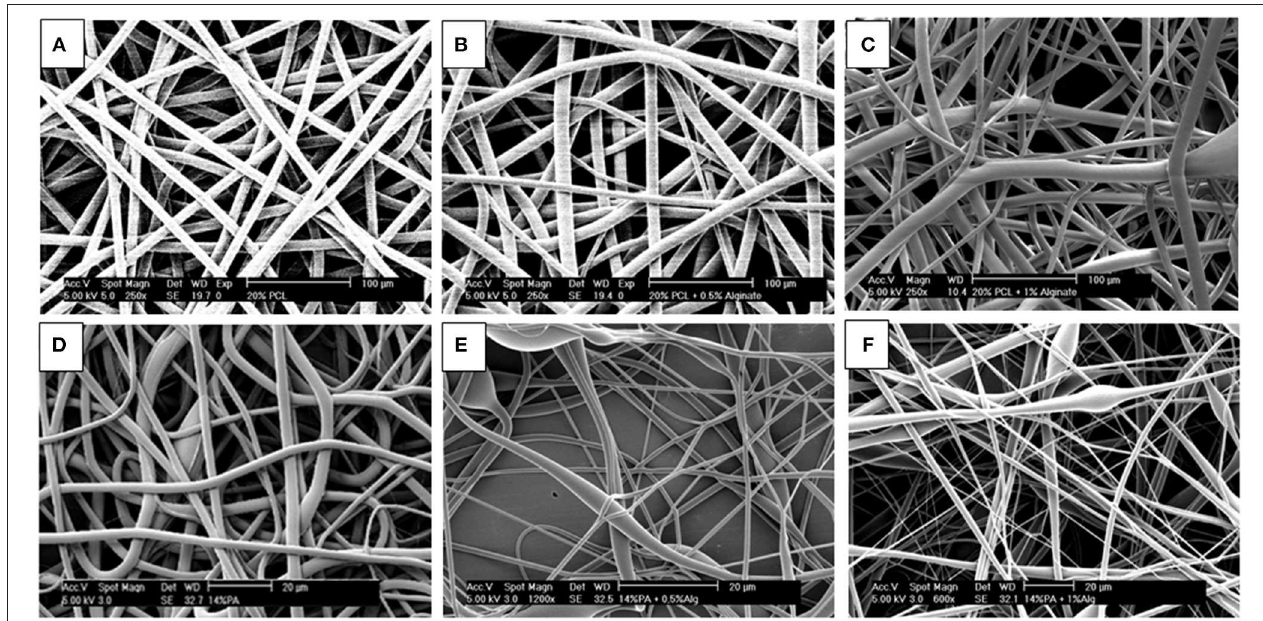
FIGURE 1 | SEM micrographs of electrospun scaffolds made of: (A) 20% PCL fibers, (B) 20% PCL + 0.5% Alginate fibers, (C) 20% PCL + 1% Alginate fibers, (D) 14% PEOT/PBT fibers, (E) 14% PEOT/PBT + 0.5% Alginate fibers, and (F) 14% PEOT/PBT + 1% Alginate fibers. Flow rate: (A,C,D,E) 3.5 ml/h; (B) 1.5 ml/h; (F) 2.5 ml/h. Air gap: 25cm. Scale bar: (A–C) 100 µ m & (D–F) 20 µ